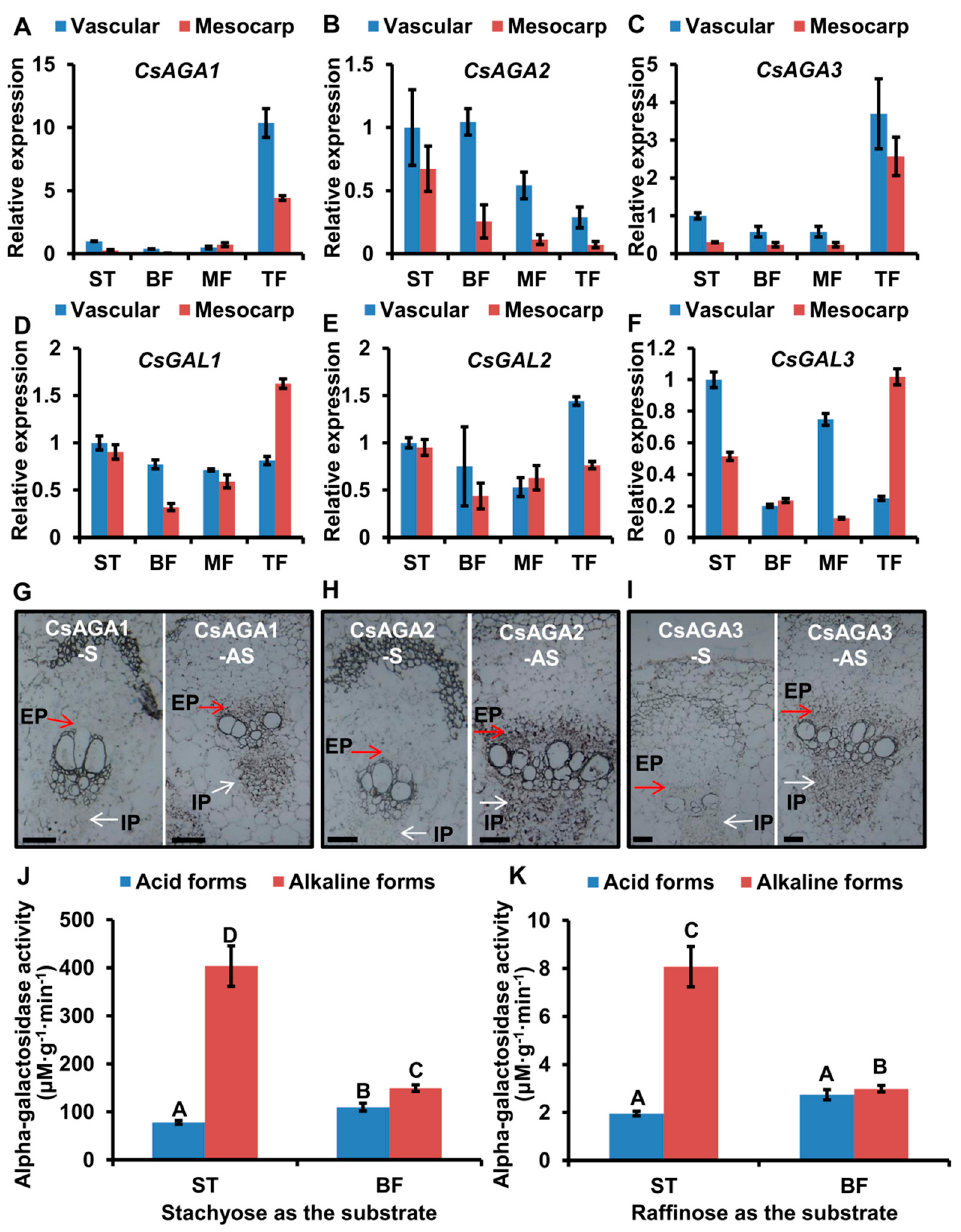
Figure 3. The expression of α -galactosidase genes in fruit. ( A – C ) Relative expression showed that α -galactosidase genes of alkaline forms ( CsAGA1 ( A ), CsAGA2 ( B ) and CsAGA1 ( C )) were preferred expressed in phloem tissue. ( D , E ) Relative expression showed that α -galactosidase genes of acid forms ( CsGAL1 ( D ), CsGAL2 ( E ) and CsGAL3 ( F )) did not show the prefer expression in phloem tissue by qRT-PCR. The bars represent standard deviation (SD) of three biological replicates. 18S rRNA acted as reference gene and relative amounts were normalized with respect to the expression in vascular of stalk. ( G – I ) In situ hybridizations showed that α -galactosidase genes of alkaline forms ( CsAGA1 ( G ), CsAGA2 ( H ) and CsAGA3 ( I )) were prefer expressed in phloem. The anti-sense probe was used for detecting the expression of α -galactosidase genes of alkaline forms (right). The sense probe was used for in situ hybridization in fruit as a negative control (left). Vascular bundles were labelled, with the IP (internal phloem) marked with white arrows and EP (external phloem) marked with red arrows. Bars = 100 μ m. ( J , K ) Alpha-galactosidase activity of alkaline forms was higher than acid forms when Sta ( J ) or Raf ( K ) acted as the substrate. Alpha-galactosidase activities in stalk (ST) and basal part (BF) of fruit were measured.